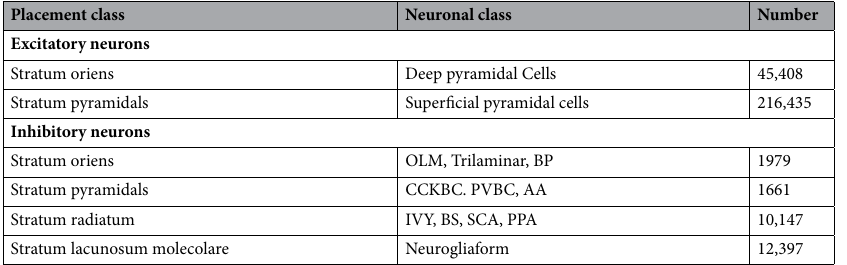
Table 1. The Table shows the numerical representations of Excitatory Neurons (Deep and Superficial Pyramidal cells) and Inhibitory neurons (Oriens Lacunosum moleculare cells—OLM; Trilaminar